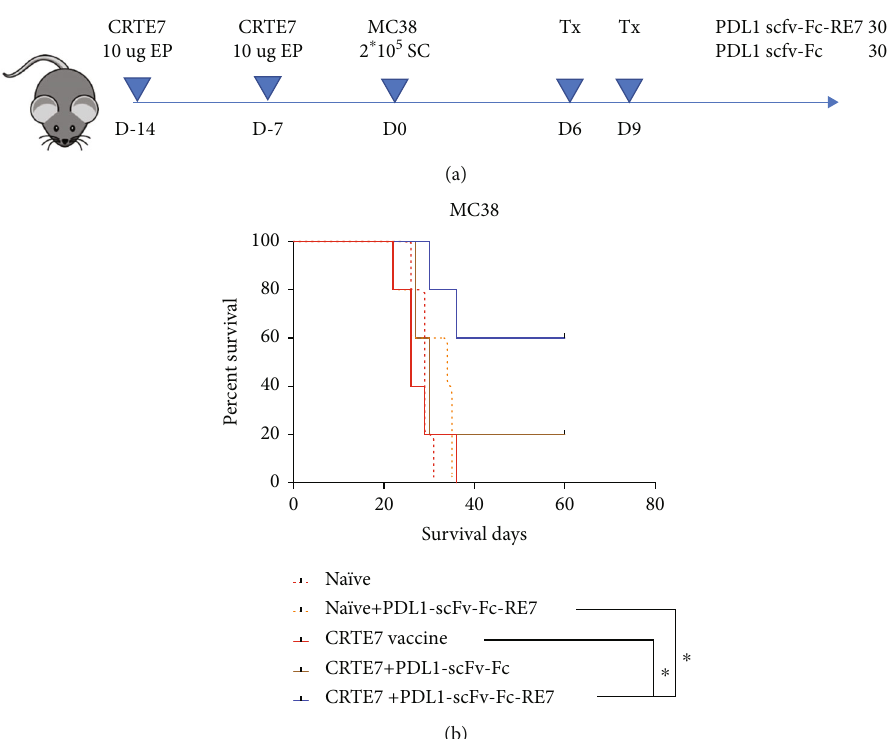
Figure 5: In vivo tumor treatment experiment using MC38 tumor-bearing mice treated with either PD-L1-scFv-Fc or PD-L1-scFv-Fc-RE7. (a) Schematic diagram of the experiment. C57BL/6 mice (5 per group) were vaccinated twice with 10 μ g pcDNA3-CRTE7 DNA vaccine intramuscularly followed by electroporation at one-week intervals. Vaccinated mice were challenged with 2 × 10 5 MC38 tumor cells one- week post fi nal vaccination. Tumor-injected mice were then treated with 30 μ g per mouse of PDL1-scfv-Fc-R7, PDL1-scfv-Fc, or no treatment twice at 3-day intervals starting 6 days after MC38 tumor challenge. (b) Kaplan – Meier survival was analyzed in tumor-bearing mice treated with di ff erent